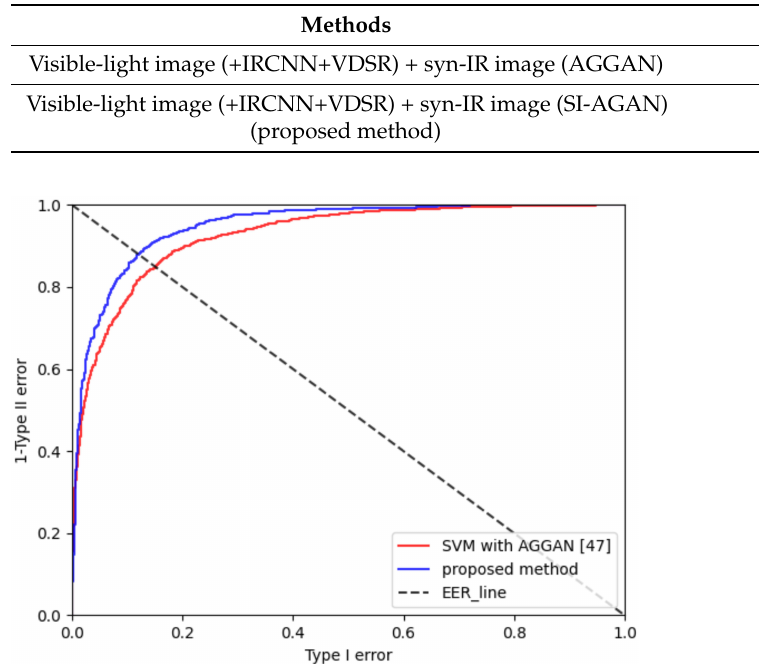
Figure 19. ROC curves of gender recognition accuracies using score-level fusion. (SVM with AGGAN [47] refers to Visible-light image(+IRCNN+VDSR) + syn-IR image (AGGAN)